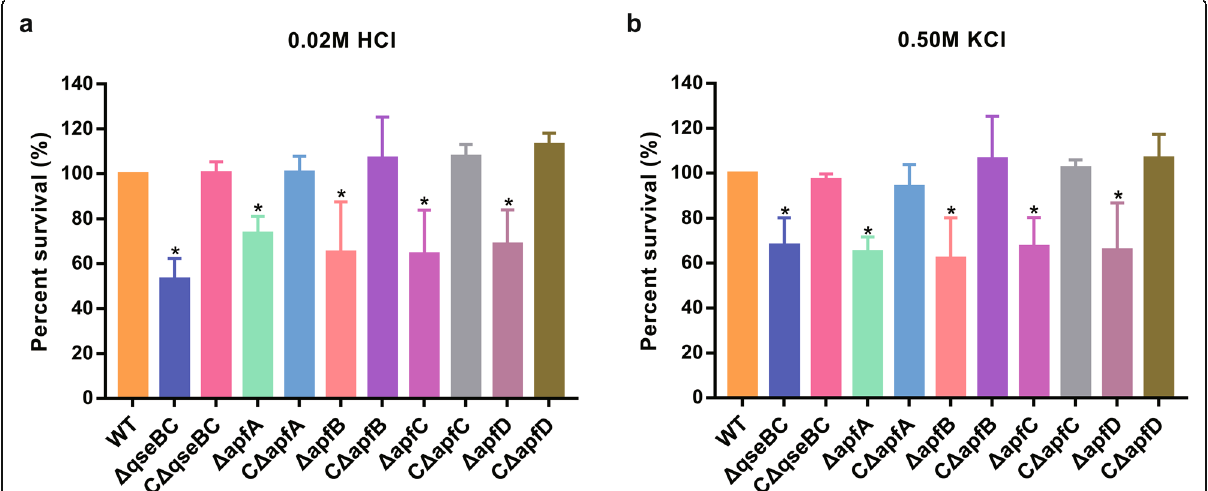
Fig. 4 Acidic and osmotic stress resistance assays. WT S4074, Δ qseBC , Δ apfA , Δ apfB , Δ apfC and Δ apfD were treated with 0.02 M HCl ( a ) and 0.50 M KCl ( b ) or tryptic soy broth and incubated for 3 h at 37 °C. Then the bacterial survival rates were calculated. Data presented are the mean ± SD ( N = 3). * P < 0.05